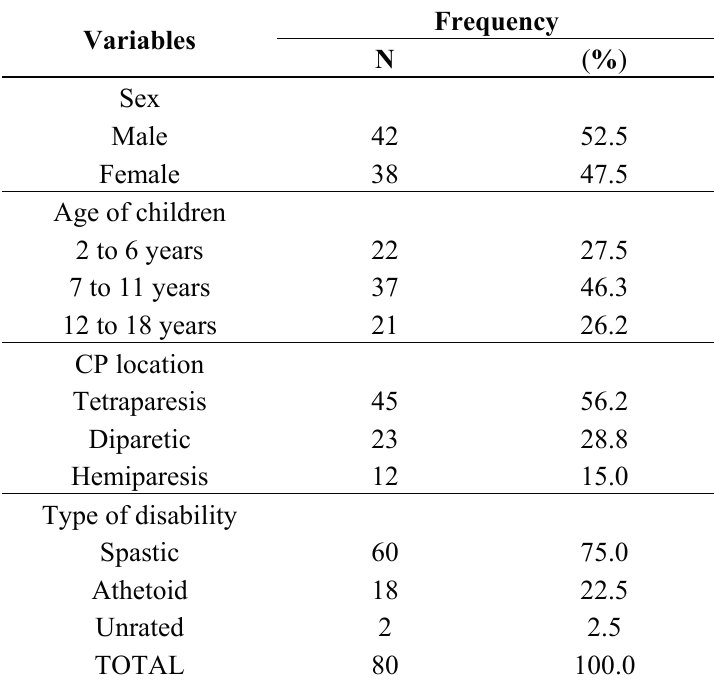
Table 2. Sample characteristics according to sex, age, CP location, type of disability, caregiver education and monthly family income.